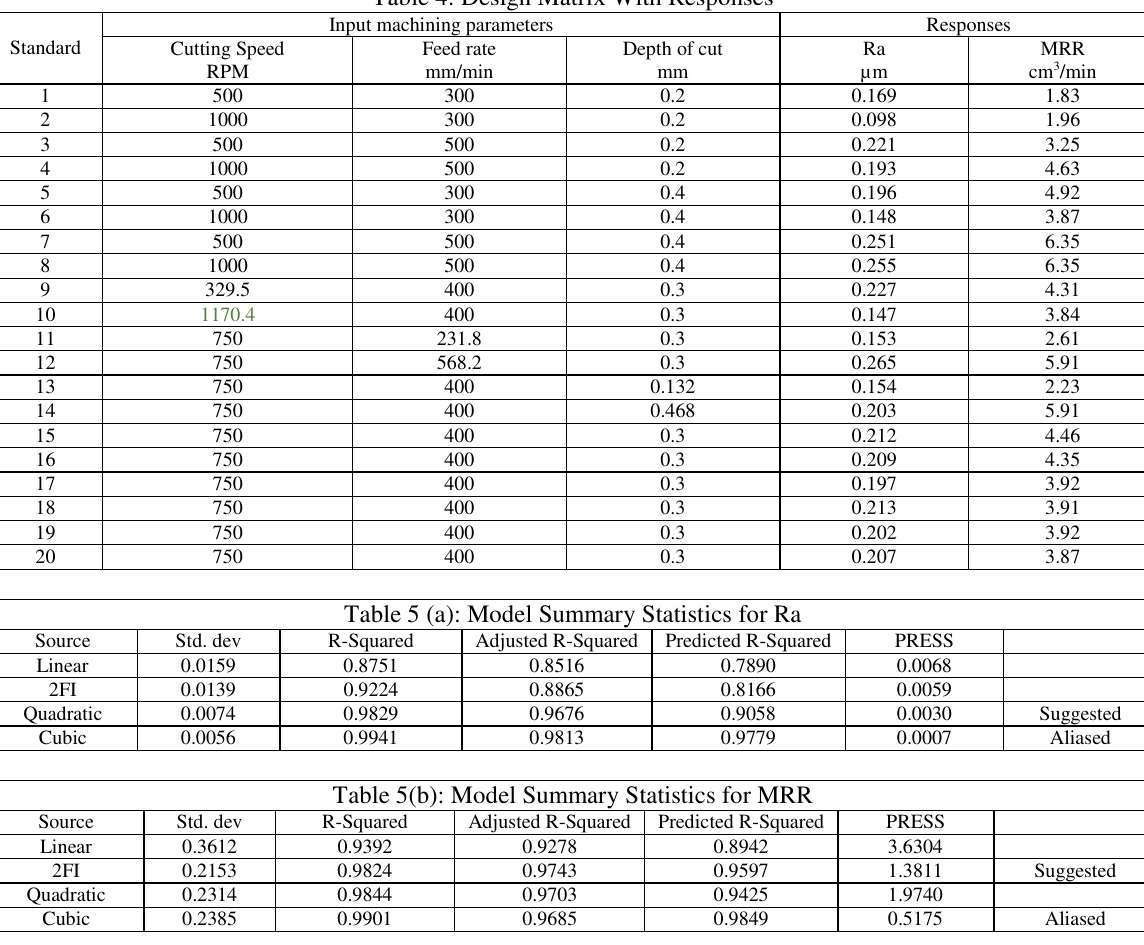
Table 4: Design Matrix With